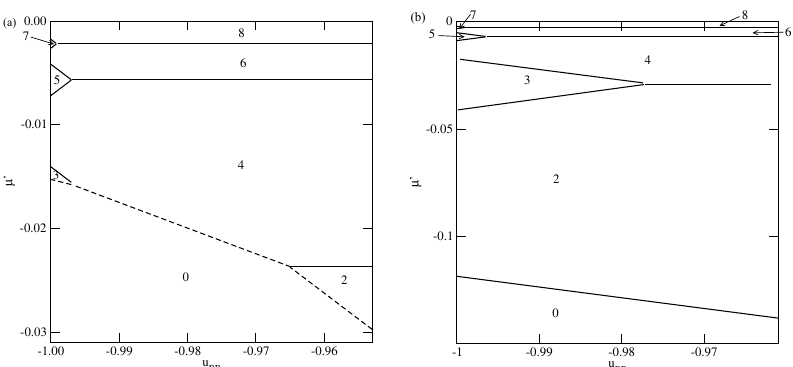
− 1.0. In Figure 4, we present two ground state phase diagrams, for V and V o = − 1.0 (Figure 4b).